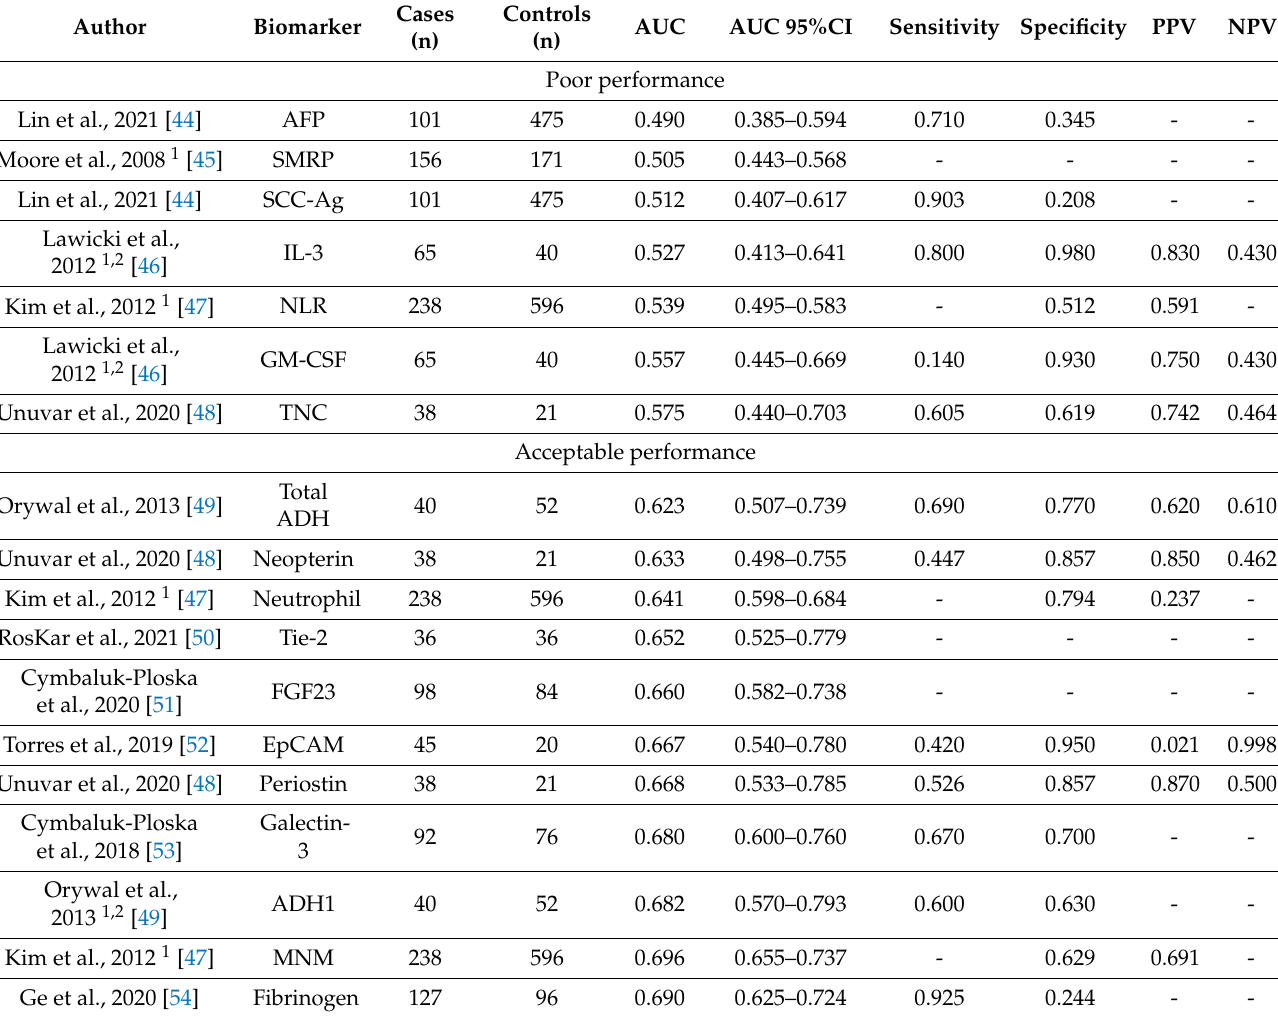
Table 5. Summary table of the performance of all proteins not eligible for inclusion in